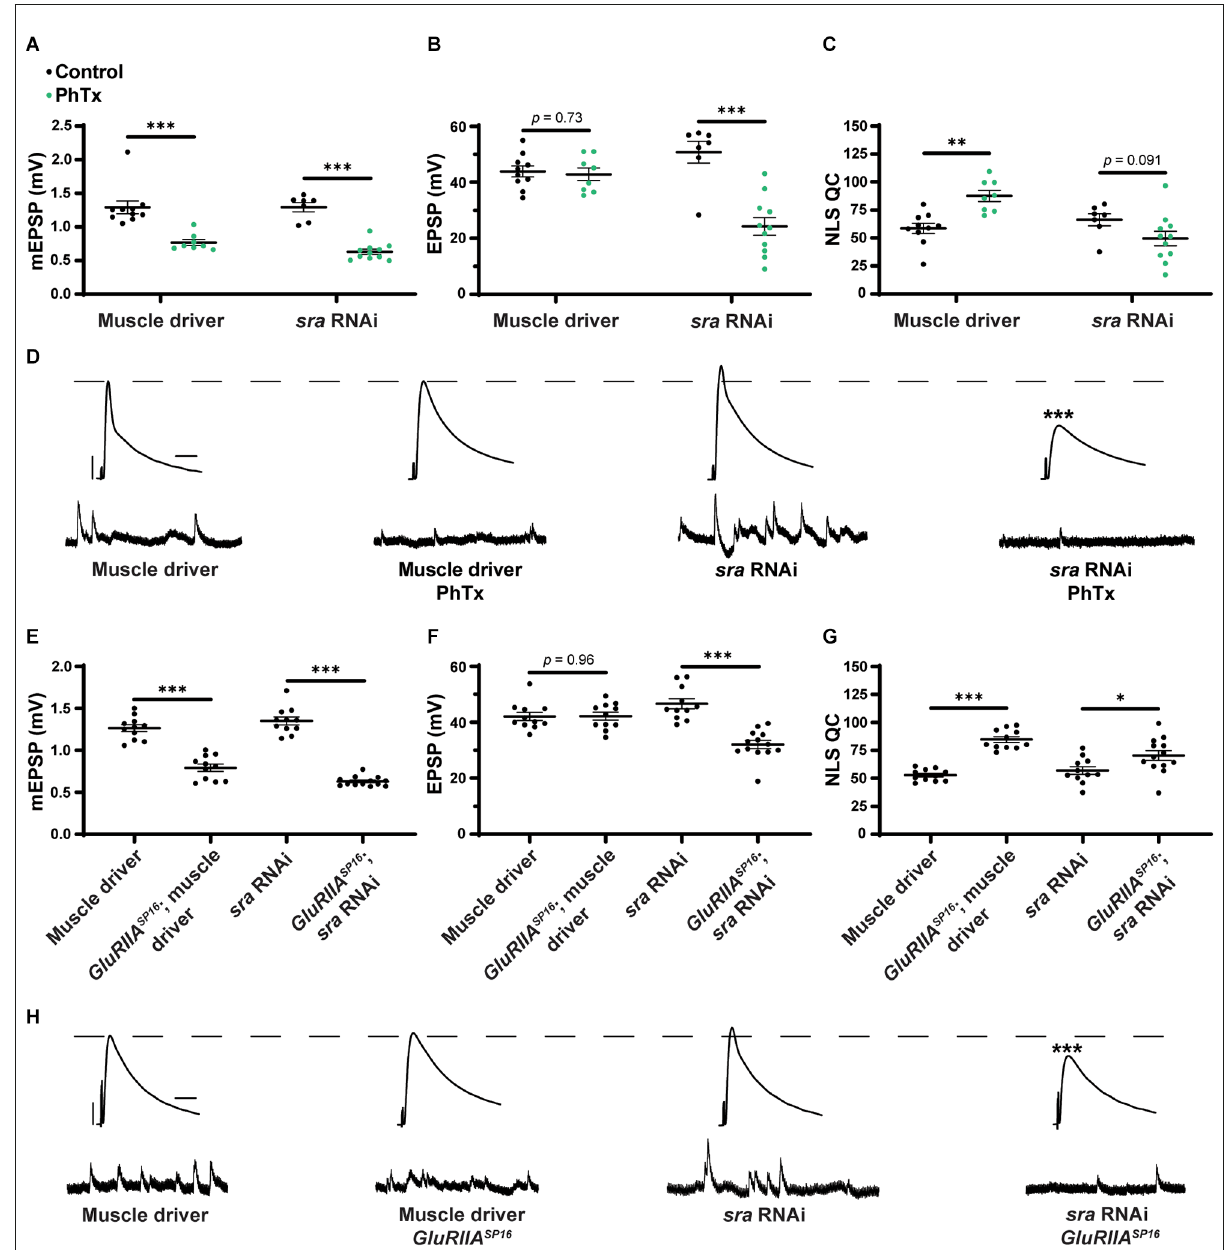
FIGURE3 Acute expression of presynaptic homeostatic potentiation requires muscle expression of sra but maintenance does not. (A–C) Quantification showing average mEPSP amplitude, EPSP amplitude, and NLS quantal content in post-GAL4 control and post-GAL4 driven sra RNAi. Black points show DMSO control synapses, while green points show synapses treated with PhTx. (D,H) Representative electrophysiological traces of EPSPs (above) and mEPSPs (below). Scale bars for all traces are y = 10 mV (1 mV), x = 20 ms (500 ms) for EPSPs (mEPSPs). (E–G) Quantification